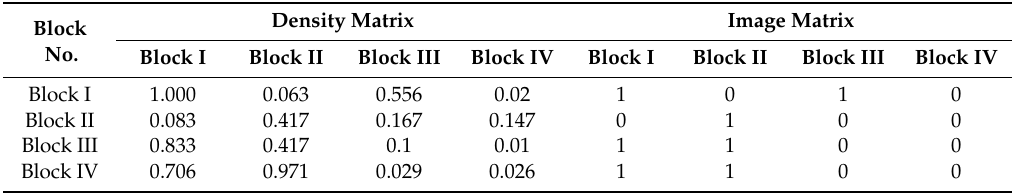
Table 9. Density matrix and image matrix of the ANTCE